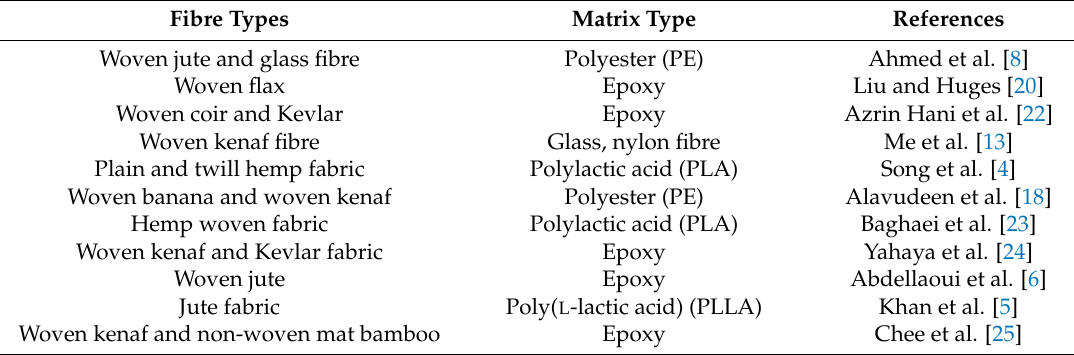
Table 1. Some reported studies on woven natural fibre reinforced polymer